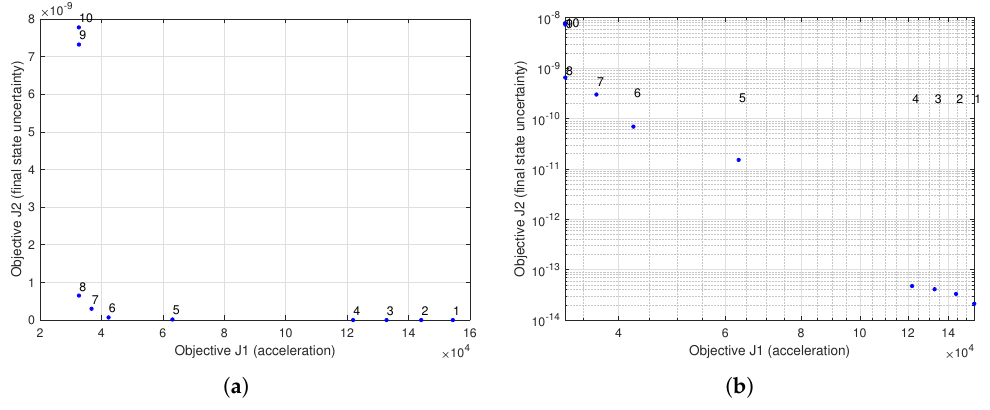
Figure 4. Pareto Front for the two-objective problem. ( a ) Linear scale; ( b ) Log-log scale.